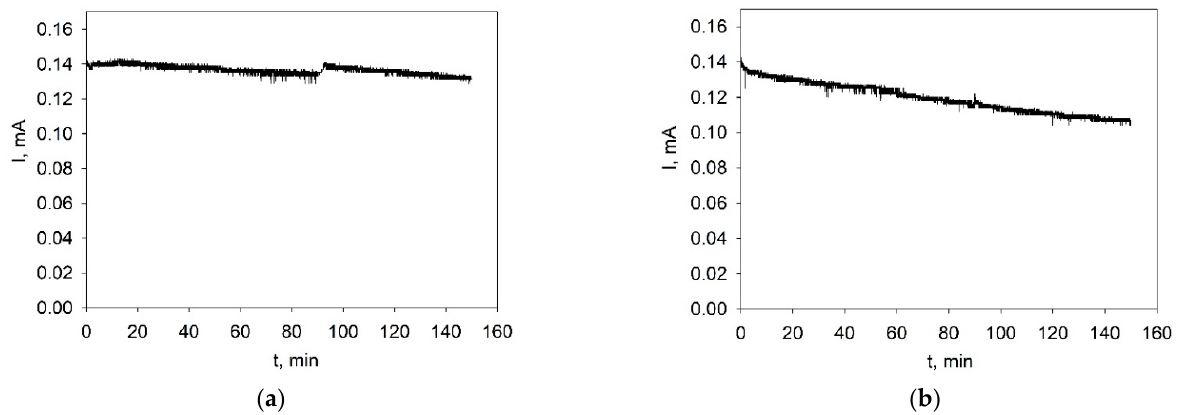
Figure 8. Dependences of current on time during EPD at a constant electric field of 20 V/cm from suspensions: ( a )-YLO_iA_2; ( b )-YLO_iA_3.